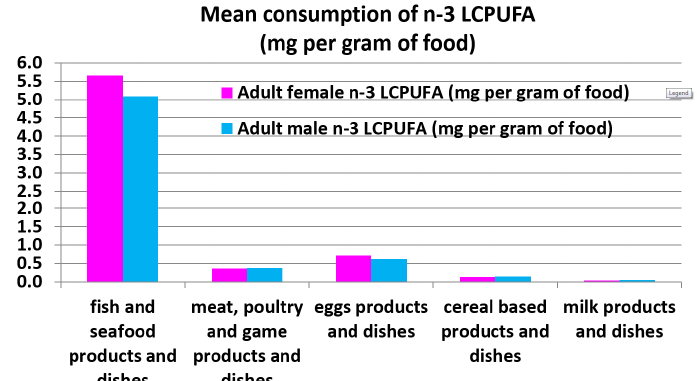
Figure 4. The actual adult female and males (19+ years) mean consumption of n ‐ 3 LCPUFA expressed as mg per gram of food for the various food groups.